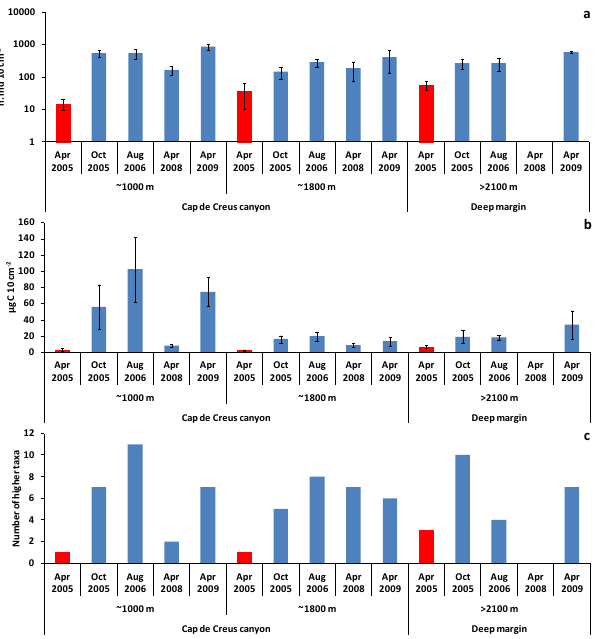
Fig. 3. Spatial and temporal variation in meiofaunal abundance (a) , biomass (b) and richness of higher taxa (c) in the Cap de Creus Canyon and deep margin. Red bars indicate DSWC. Pusceddu et al. Major consequences of an intense Dense Shelf Water Cascading event on deep-sea benthic trophic conditions and meiofaunal biodiversity